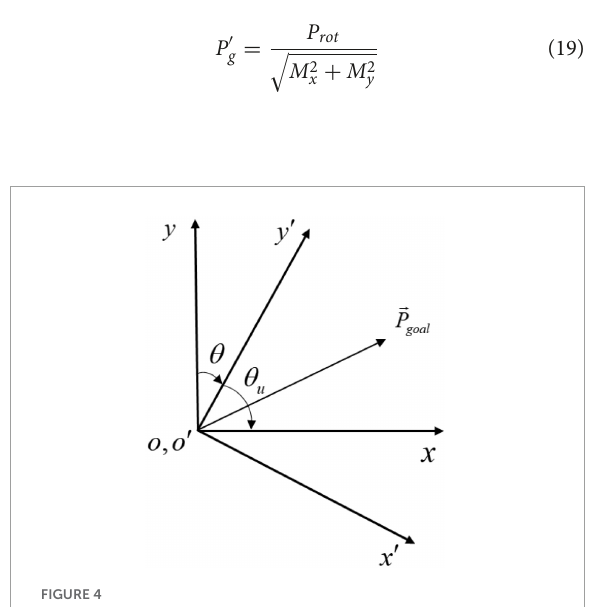
FIGURE4 Coordinate transformation